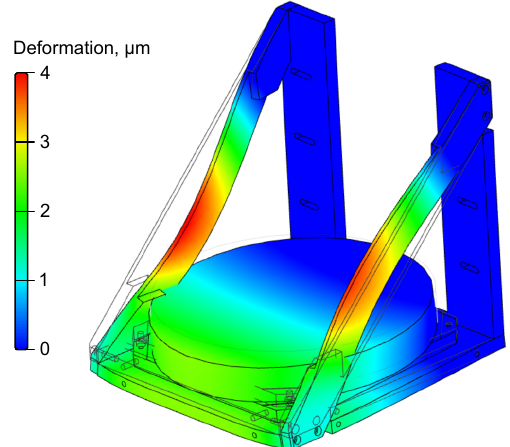
Figure 4. FEM calculations of the maximal deformation of the mount of the primary mirror during the vertical adjustment in the cabinet. The deformation intensity is given by the color code.